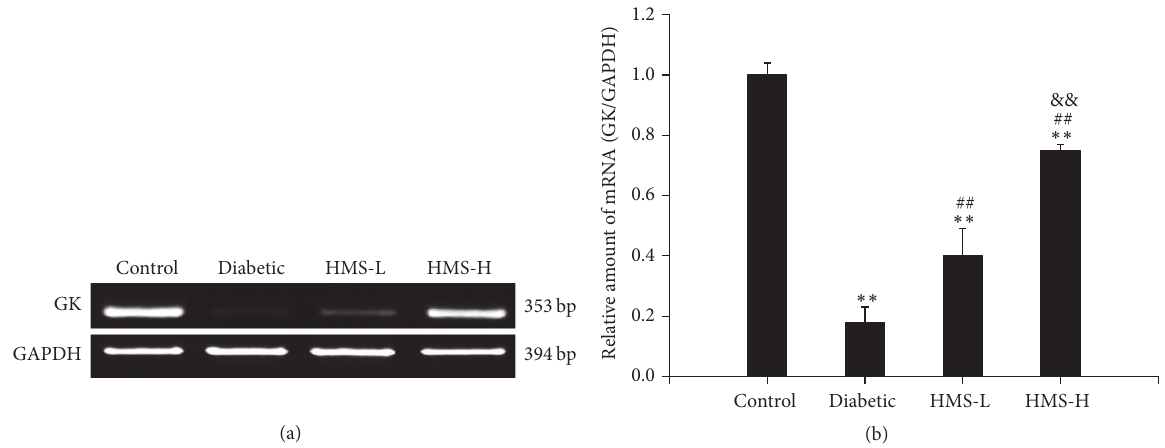
Figure 7: Effects of HMS5552 on the expression of GK mRNA in the rat liver. The expression of GK was detected by semiquantitative RT- PCR (a), and the intensities of the bands were normalized against that of GAPDH (b). HMS-L group, low-dose (10mg/kg) HMS5552-treated diabetic group; HMS-H group, high-dose (30mg/kg) HMS5552-treated diabetic group. The data are expressed as the mean ± SD ( 𝑛 = 6 ). ∗∗ 𝑃 < 0.01 , compared with the control group; ## 𝑃 < 0.01 , compared with the diabetic group; && 𝑃 < 0.01 , compared with the HMS-L